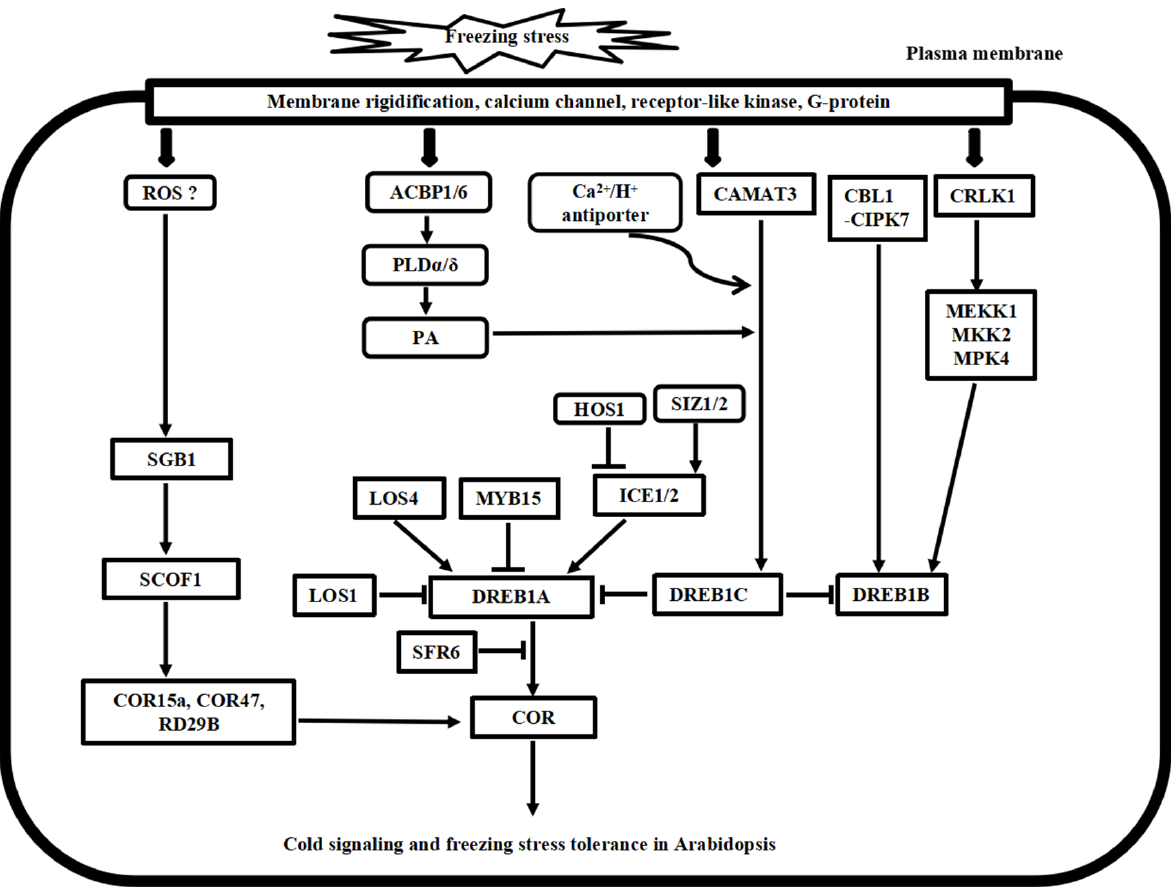
Figure 2. Putative model of cold stress signaling networks toward freezing stress tolerance in Arabidopsis . The cold-induced calcium signature in the cytosol is recognized by the calcium sensor proteins, including CaM, CDPK, CBL1/CIPK7, and CAMAT3, as well as the bZIP transcription factor SGB1 pathway. In addition, CRLK1-MEK1-MKK1/2-MPK4/6 cascade, ROS signaling, and phospholipid signaling work together to regulate cold stress signaling, and many ICE1-DREB transcription activators and repressors have been identified to regulate the COR gene expressions, finally leading to freezing tolerance in Arabidopsis .